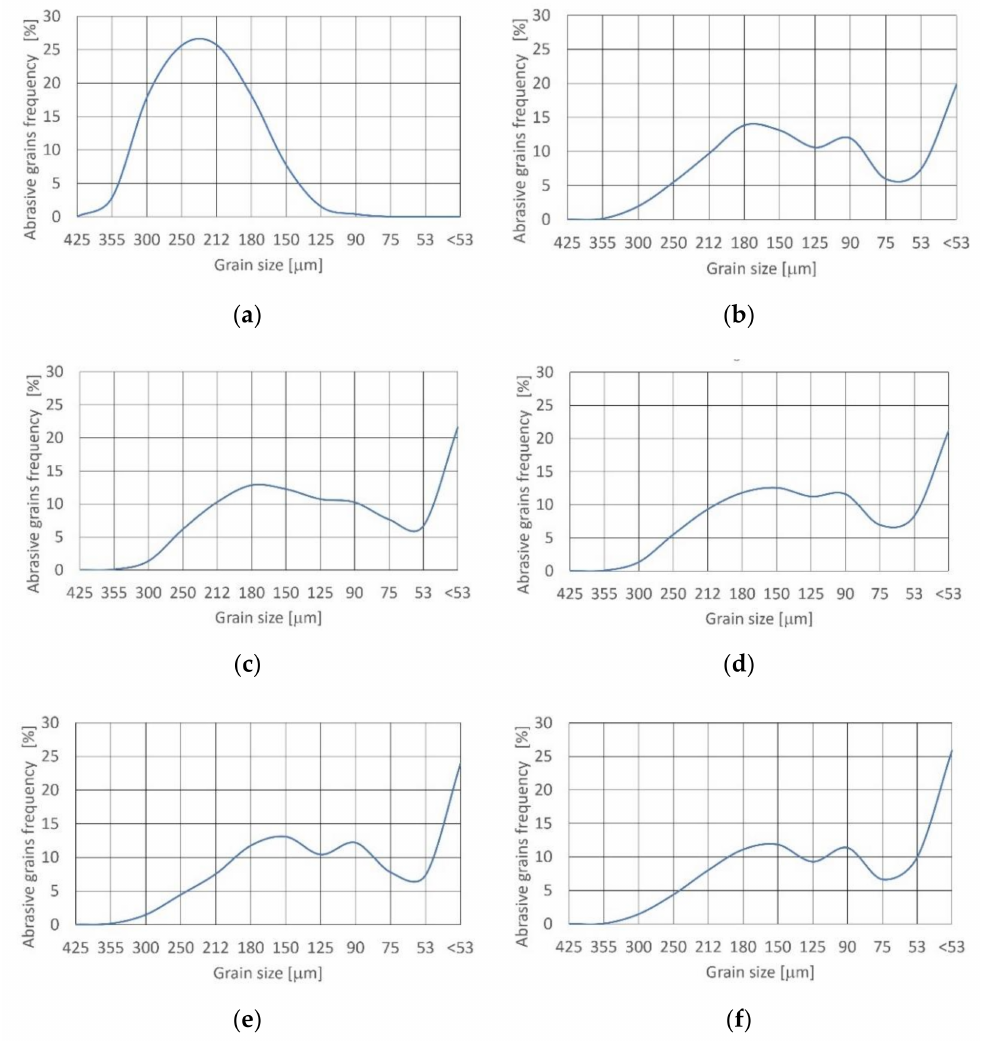
Figure 3. Size distribution of alluvial garnet grain at concentration: ( a ) fresh; ( b ) 15%; ( c ) 17.5%; ( d ) 20%; ( e ) 22.5%; ( f )